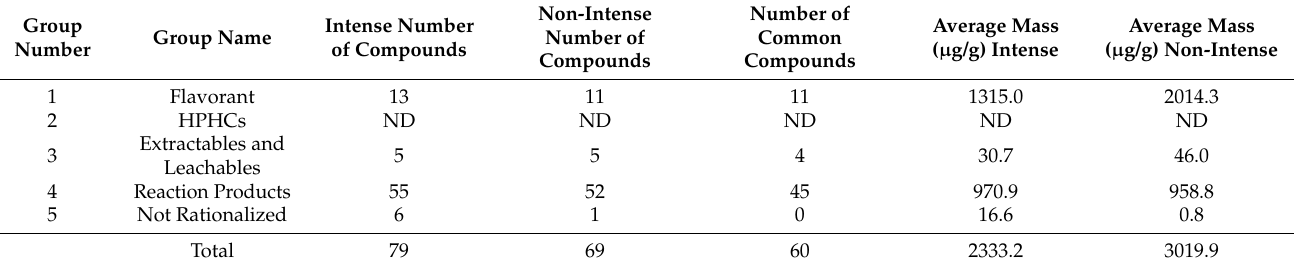
Table 7. Summary of Non-Targeted Analyses of VT3 Aerosol Using Both Puffing Regimens.